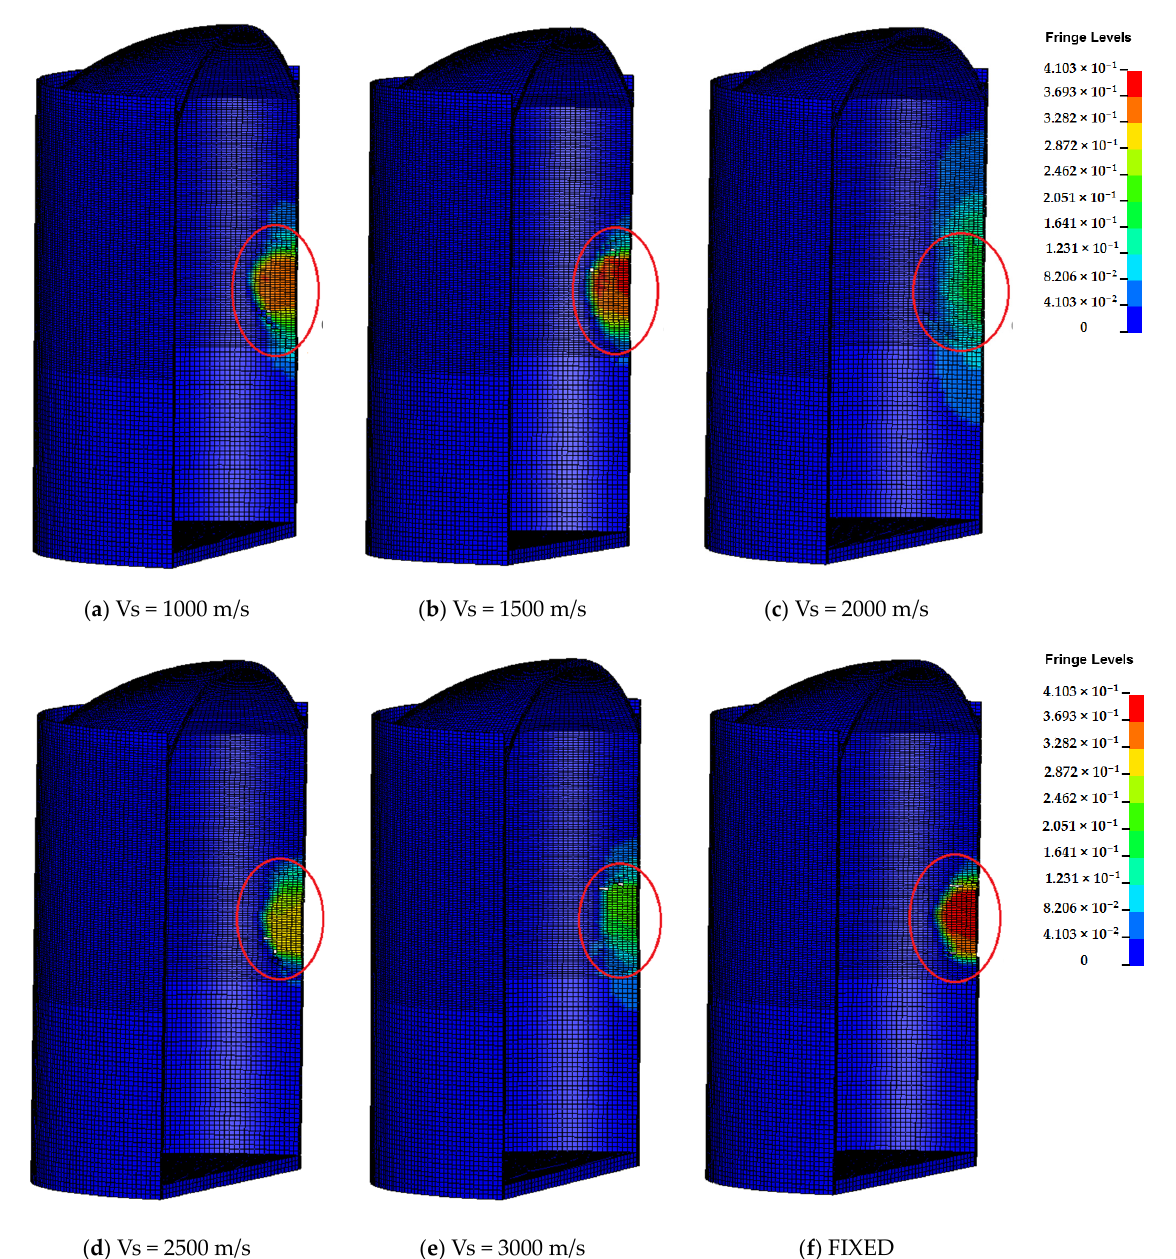
Figure 5. Contours of the maximum impact displacement and concrete peeling off area of full SC containment. ( a ) Vs